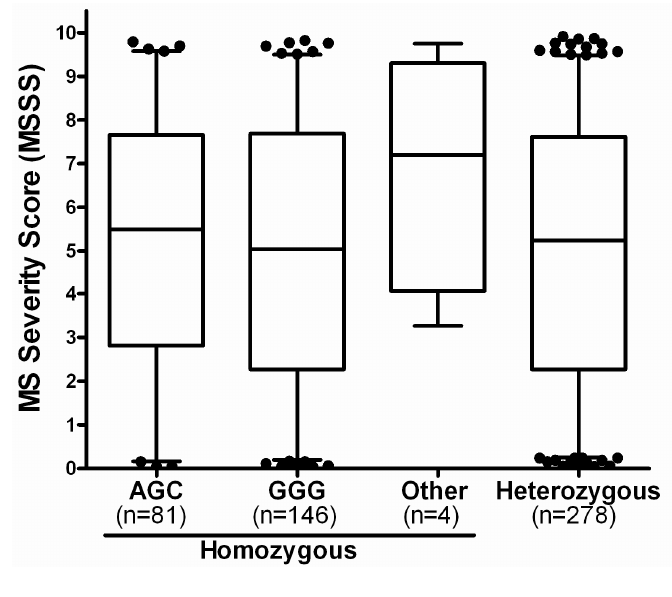
Figure 6. MSSS of patients with different IL6 promoter region haplotypes. There were no significant differences between patients with different